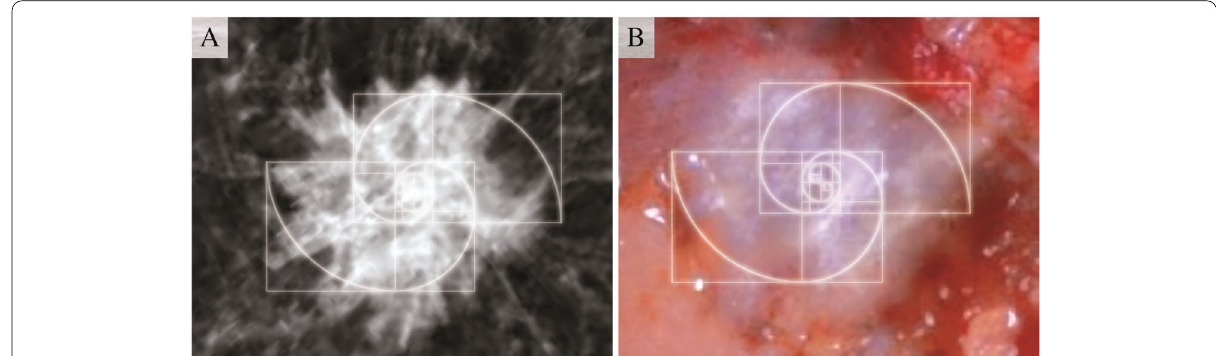
Fig. 5 Mammography Breast Cancer By PhiΦBreast Pattern & Spiral Tumor Growth Imitating The Golden Ratio Model (Φ). Mammographic X-ray seen on a closeup view large spiculated carcinoma projected over a background primarily of soft tissue parenchyma as spiral growth pattern of breast cancer in perfect configuration with the Golden Ratio (Φ) and Fibonacci Spiral ( A ). Fresh tissue specimen of the resected breast area and the tumor within. Extraordinary image showing the tumor growth imitating the Golden Ratio model (Φ) with a different fractal geometry, generating an abnormal spiral infiltrating healthy breast tissue due to the neoangiogenesis, imbalance of the bioeletric activity of the cells and the action of gravity (g) ( B